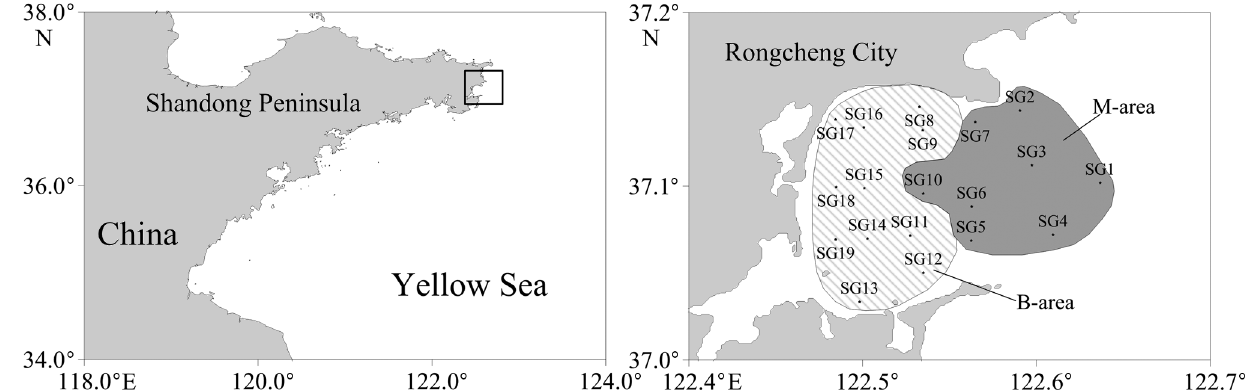
Fig. 1. Study area and location of sampling stations in Sanggou Bay, China. Grey area: macroalgae culture (M-area), dashed area: bivalve culture